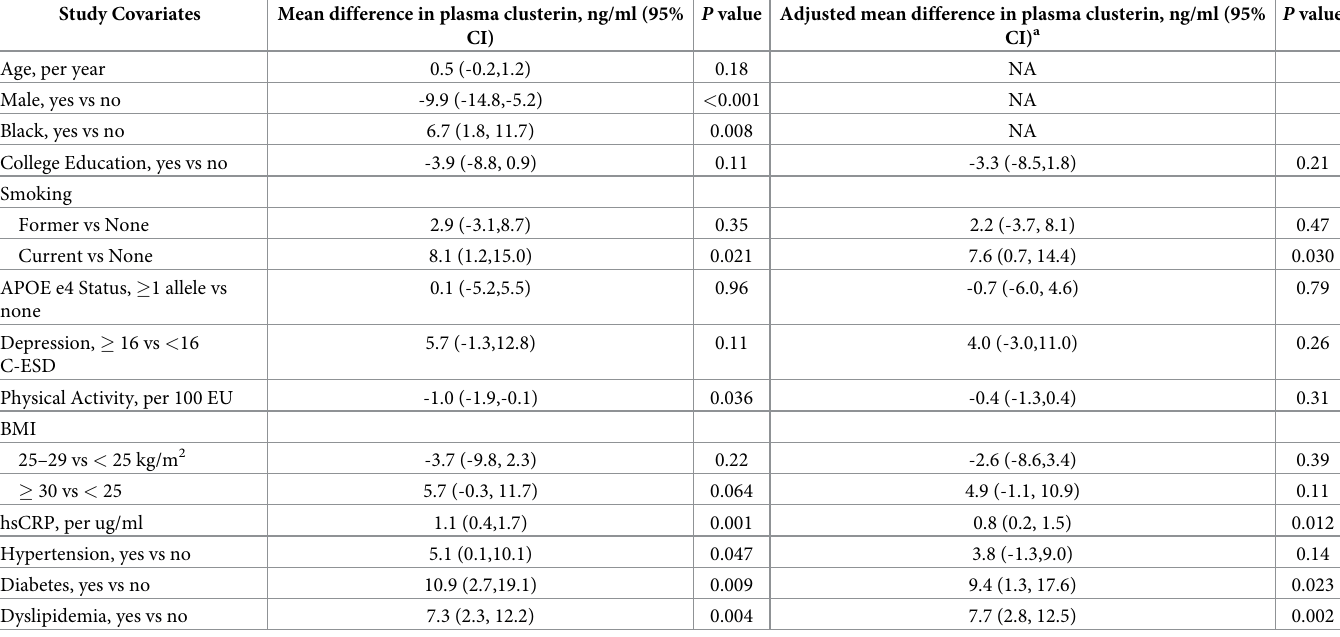
Table 2. Mean differences in plasma clusterin for different study